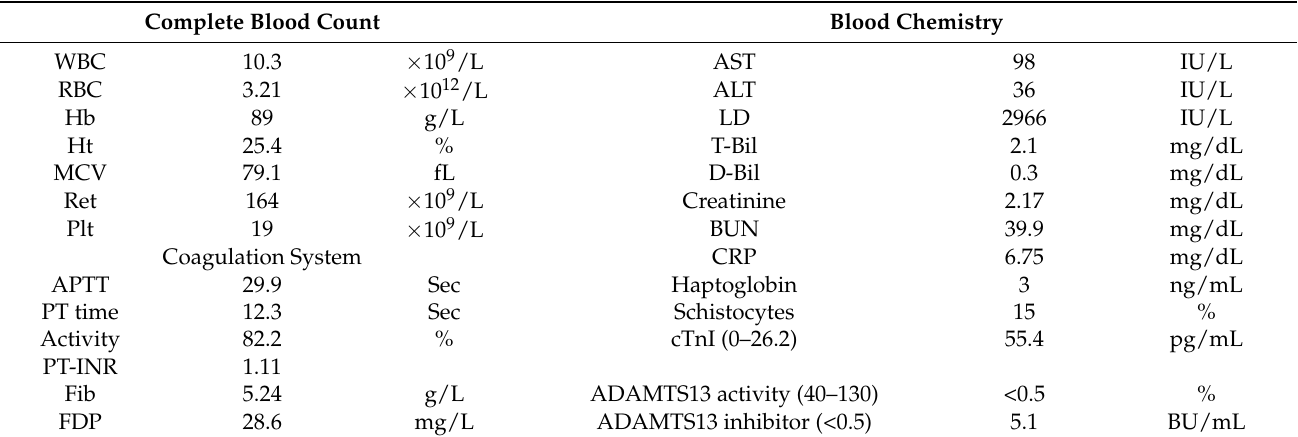
Table 1. Laboratory data obtained on admission to our